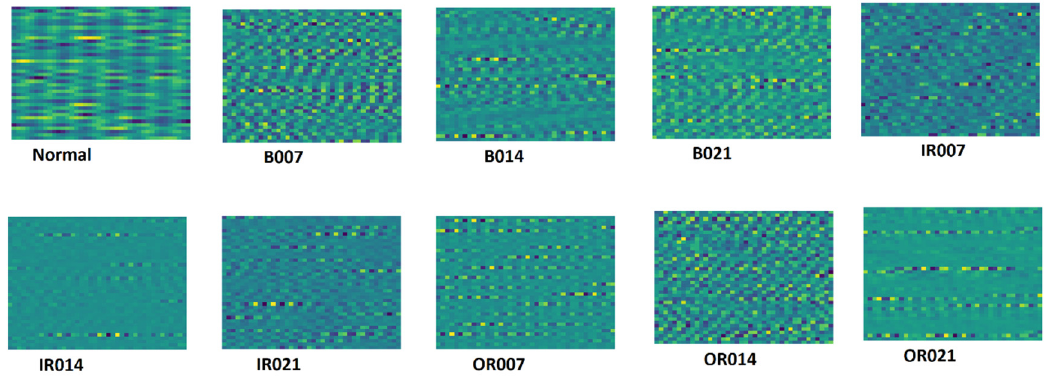
Figure 8. Network architecture of 2-D CNN model used for comparison.